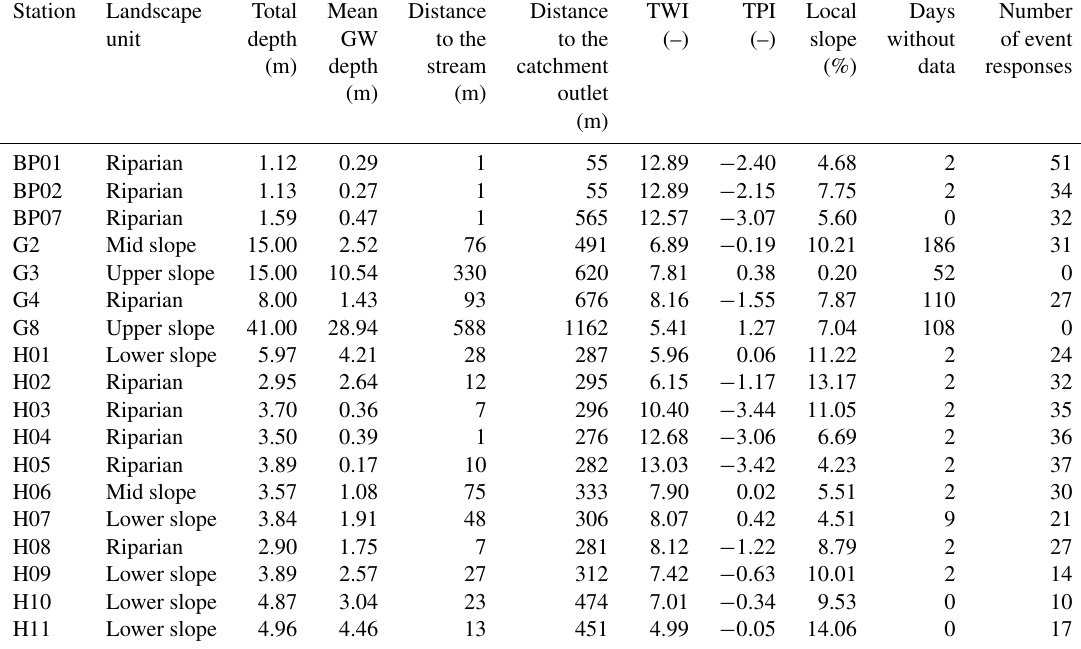
Table 1. Groundwater (GW) measurement stations in the HOAL used in this study. Distance to the stream and the catchment outlet are the distances along the surface flowpath from the GW station’s location to the nearest stream reach and catchment outlet, respectively. TWI and TPI are the topographic wetness and topographic position indices, respectively. The last column shows the number of events when a response was